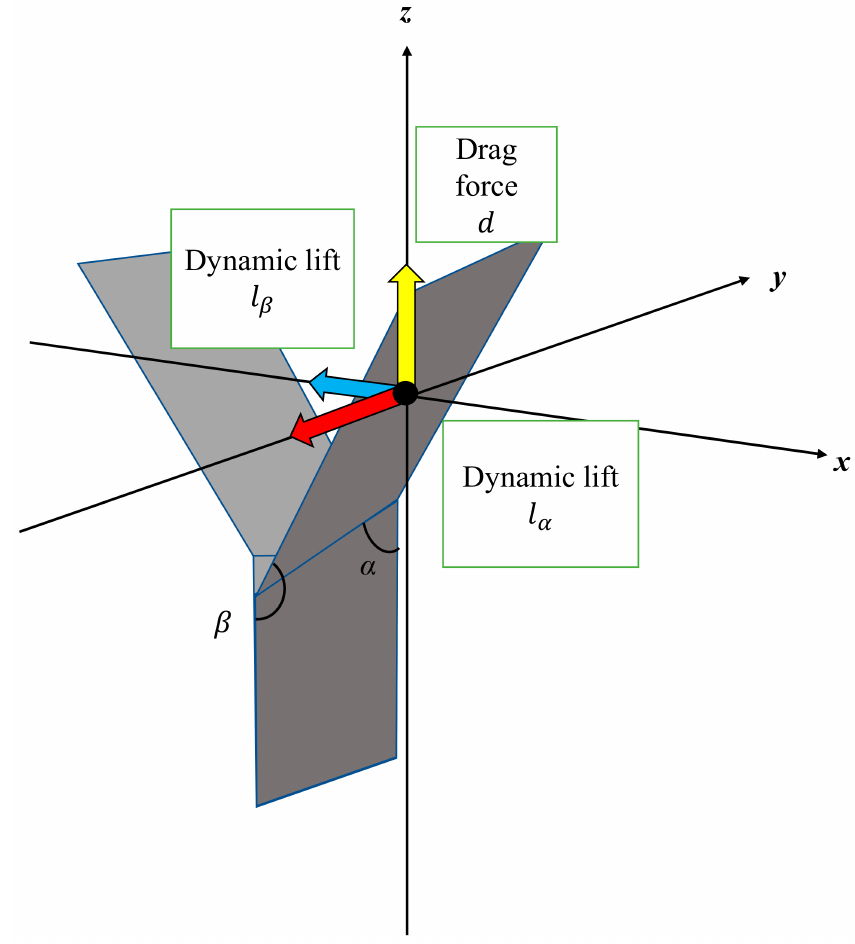
Figure 6. Forces acting on the model.